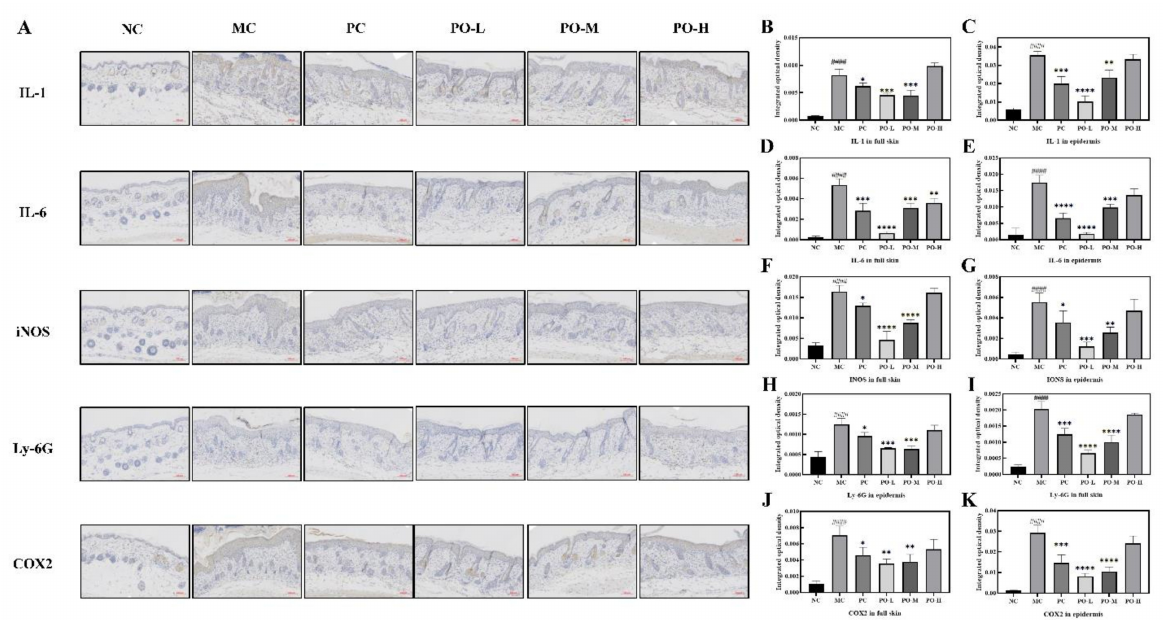
Figure 2. PO inhibited the expression of Inflammation-related factors (IL-1, IL-6, iNOS, COX2) and neutrophil maturation marker (Ly-6G). ( A ) Immunohistochemistry of IL-1, IL-6, iNOS, Ly-6G, and COX2. The target protein is stained tan. ( B , D , F , H , J ) The quantitative analysis of IL-1, IL-6, iNOS, Ly-6G, and COX2 in full skin. ( C , E , G , I , K ) The quantitative analysis of IL-1, IL-6, iNOS, Ly-6G, and COX2 in the epidermis. All quantitative analysis were performed with Image-Pro Plus 6.0 (MEDIA CYBERNETICS, USA). Data are shown as mean ± SEM (n = 8), #### p < 0.0001 vs. NC group,